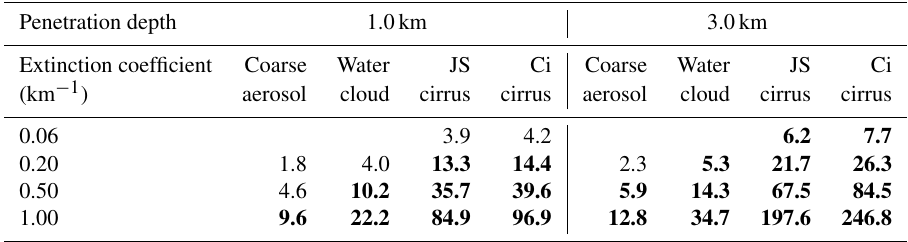
Table 2. Multiple-scattering contribution to lidar signals in per cent (%) of the single scattering. The distance to the cloud base is 8km; the lidar RFOV is 1.0mrad. Values exceeding 5% threshold are in bold font.